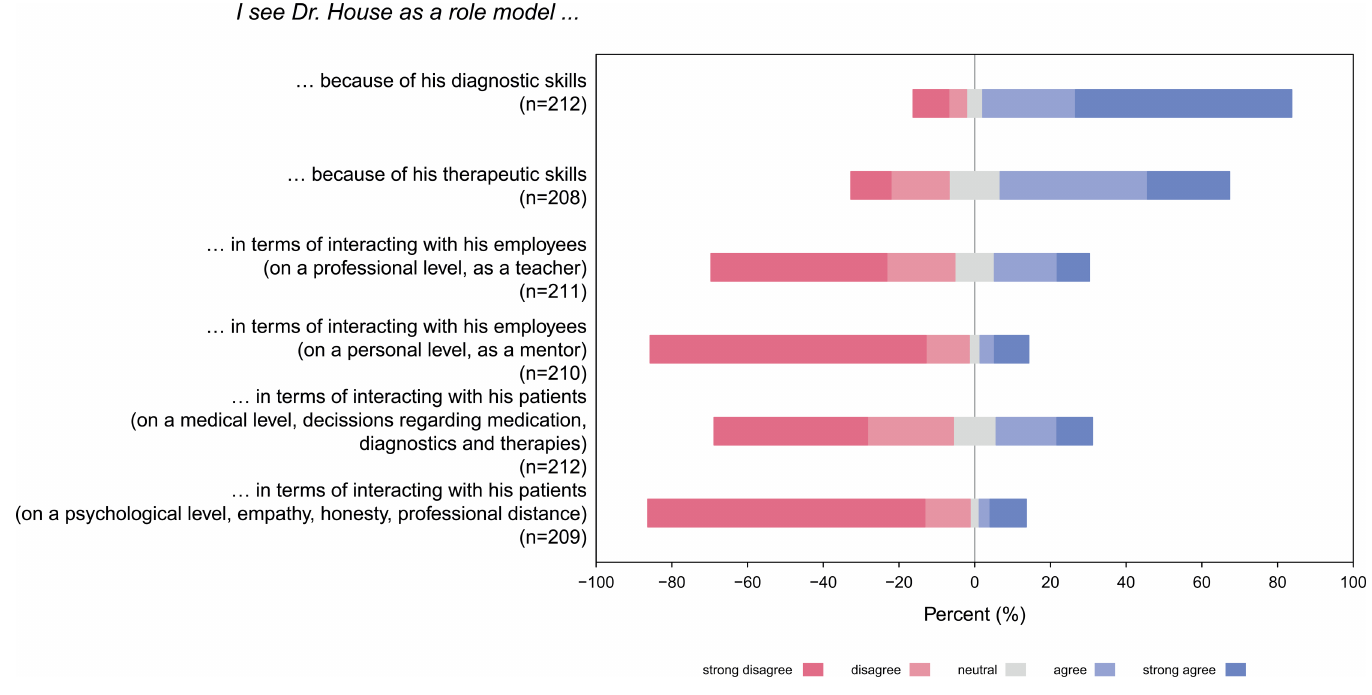
Fig 4. Evaluation of Dr. House as a potential role model.